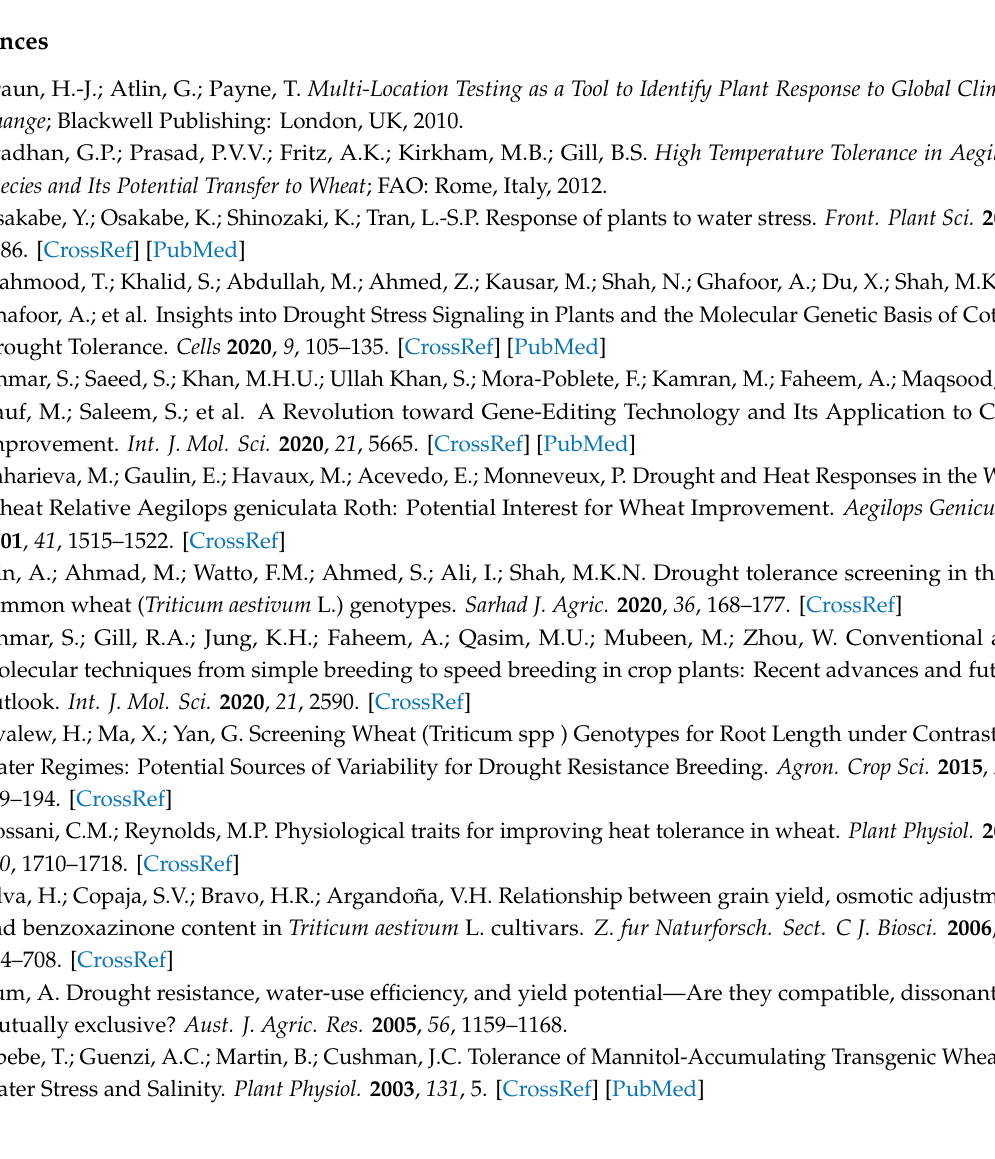
Figure S1: Biplot (Principal component analysis) for all traits under WW and DS conditions. Figure S2 Summary of biplot (Principal component analysis) for all traits under WW and DS conditions. Figure S3: Ridge traces of standardized regression coe ffi cients for increasing values of ridge parameter, for osmotic adjustment and yield components, for drought stress (DS) and well-watered (WW) respectively. Table S1: List of 30 wheat genotypes evaluated in this study. Table S2: Mean performance of 30 wheats genotypes under WW and DS environment along with heat susceptibility index for yield per plant (HSI YP ). Table S3: Cubic clustering